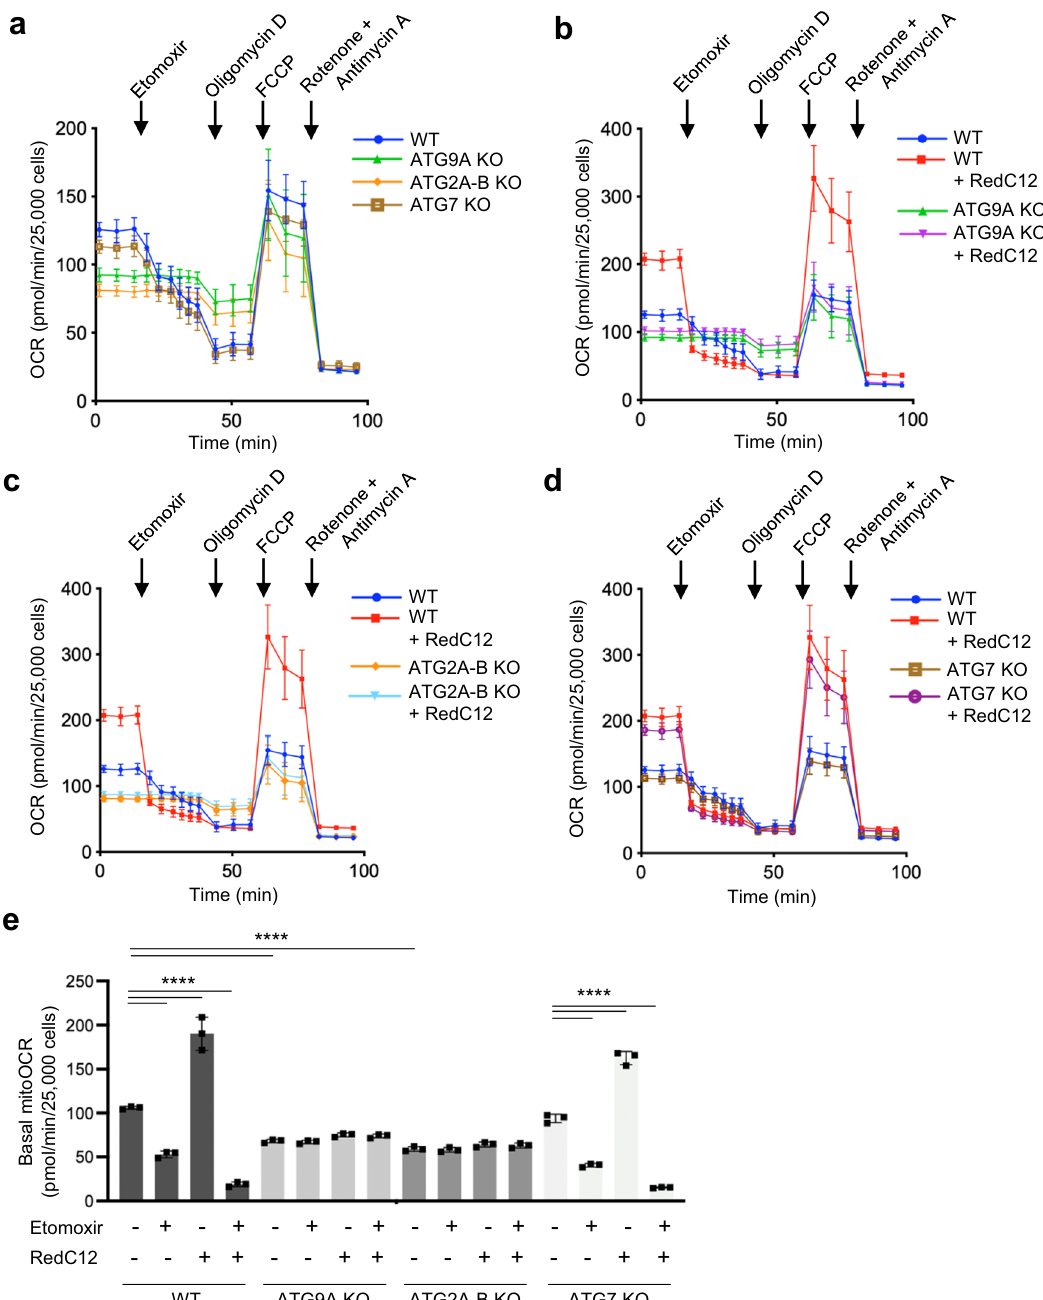
Fig. 5 ATG9A KO and ATG2A-B KO block FA β -oxidation in mitochondria. a – e Mitochondrial β -oxidation of FAs in WT and KO cell lines was analyzed by measuring the oxygen consumption rate (OCR) with a Seahorse fl ux analyzer. The contribution of FA metabolism to the OCR was determined by the addition of 4 μ M of the mitochondrial FA import inhibitor etomoxir. a Representative Seahorse analysis of OCR in WT and the indicated KO cell lines. b – d Representative Seahorse analysis showing the OCR of WT and the indicated KO cell lines in the presence or absence of 1 μ M RedC12 as an extra source of FAs. e Quanti fi cation of basal mitochondrial OCR in WT and KO cells with or without the indicated additives. Mitochondrial OCR was calculated by subtracting the OCR insensitive to rotenone plus antimycin A (last time point in a – d ) from the basal OCR. Bar graph represents the mean±SD of OCR values from three independent experiments. Statistical signi fi cance was determined using one-way ANOVA with Tukey post hoc test (**** p